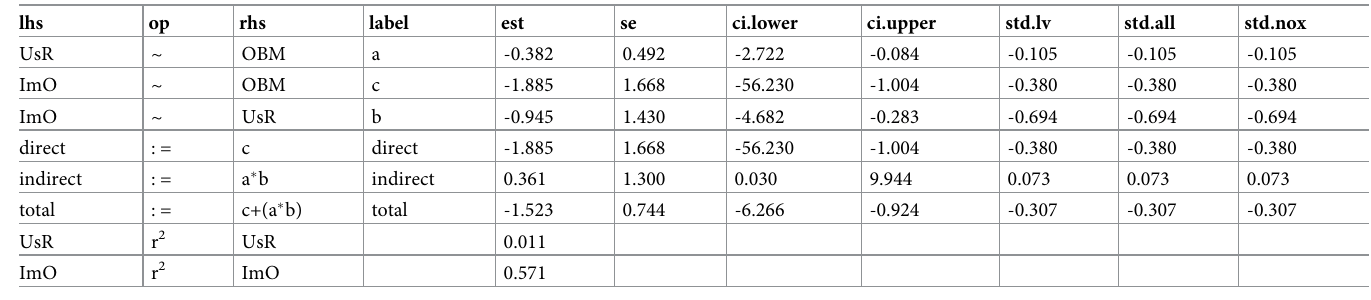
Key: lhs and rhs = Left and right hand side(of the model equation); op = operator (e.g., ~ = ‘regression operator); est = unstandardized estimates; r 2 = r squared; ci.lower and ci.upper = lower and upper confidence intervals at 90% confidence level; Std.lv = only the latent and not the observed variables are standardized; Std.all = fully standardized solution (both latent and observed) variables are standardized to have a variance of one. std.nox = estimates in which the latent variables and endogenous observed variables are standardized but the exogenous observed variables are left in their raw scale, i.e. partially standardized